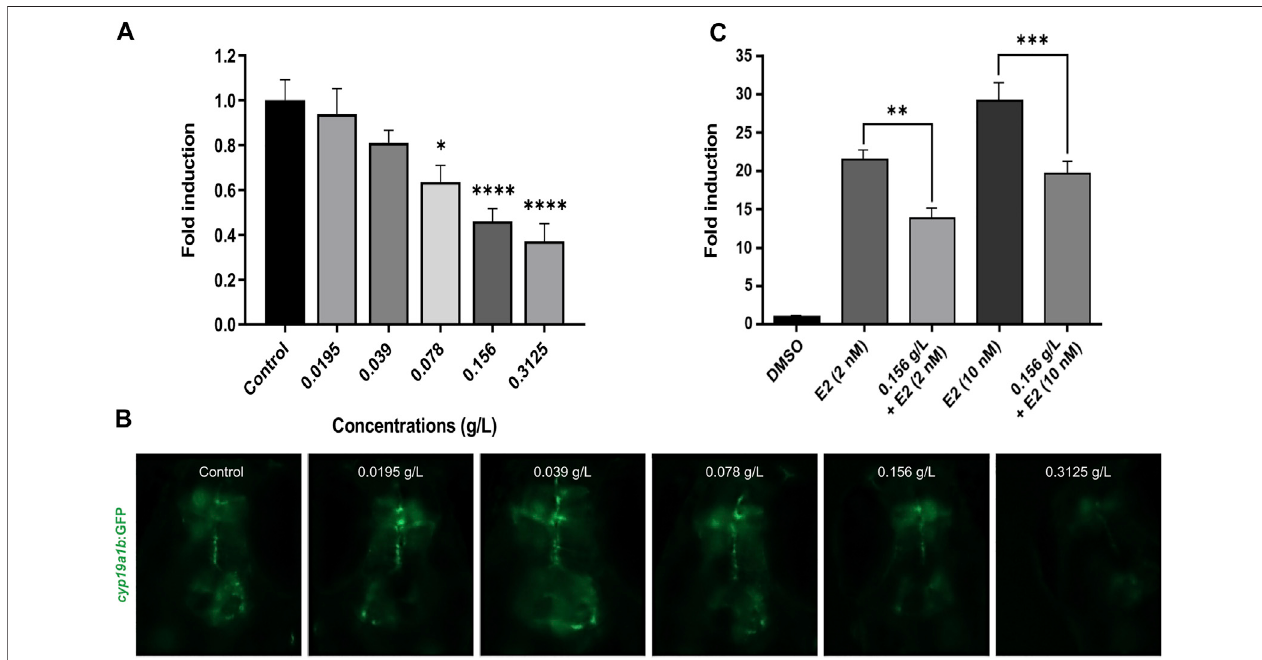
FIGURE 5 | H. lanceolatum aqueous extract possesses an anti-estrogenic activity. (A) Quanti fi cation of GFP fl uorescence and (B) representative pictures of embryos exposed to water (Control) and different concentrations of H. lanceolatum aqueous extract (g/L) for 96 h (n = 26 – 38/groupfrom 2 independent experiments). * denotes signi fi cant differences as compared to the control group (Dunn ’ s multiple comparison test, * p = 0.0438 and **** p < 0.0001). (C) Fluorescence quanti fi cation of GFP in embryos treated with control solvent (DMSO) and E2 at two different concentrations (2 and 10 nM) alone or co-exposed with H. lanceolatum aqueous extract 0.156 g/L ( n = 19 – 21/group). * denotes signi fi cant differences between groups (Dunnett ’ s multiple comparison test, ** p = 0.0011 and *** p = 0.0002). All the results are expressed as fold induction above control (means ± SEM).